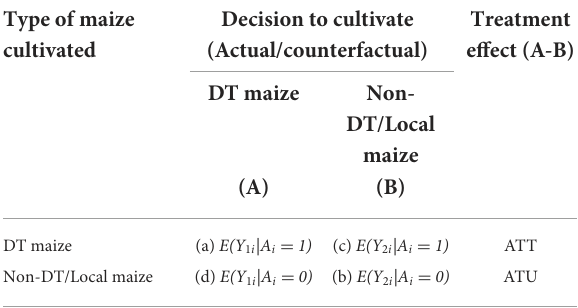
TABLE 1 Conditional expectations and treatment effects.